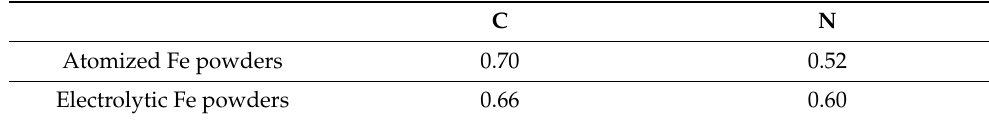
Table 4. Contents of C and N in the two kinds of Fe powders (wt.%).